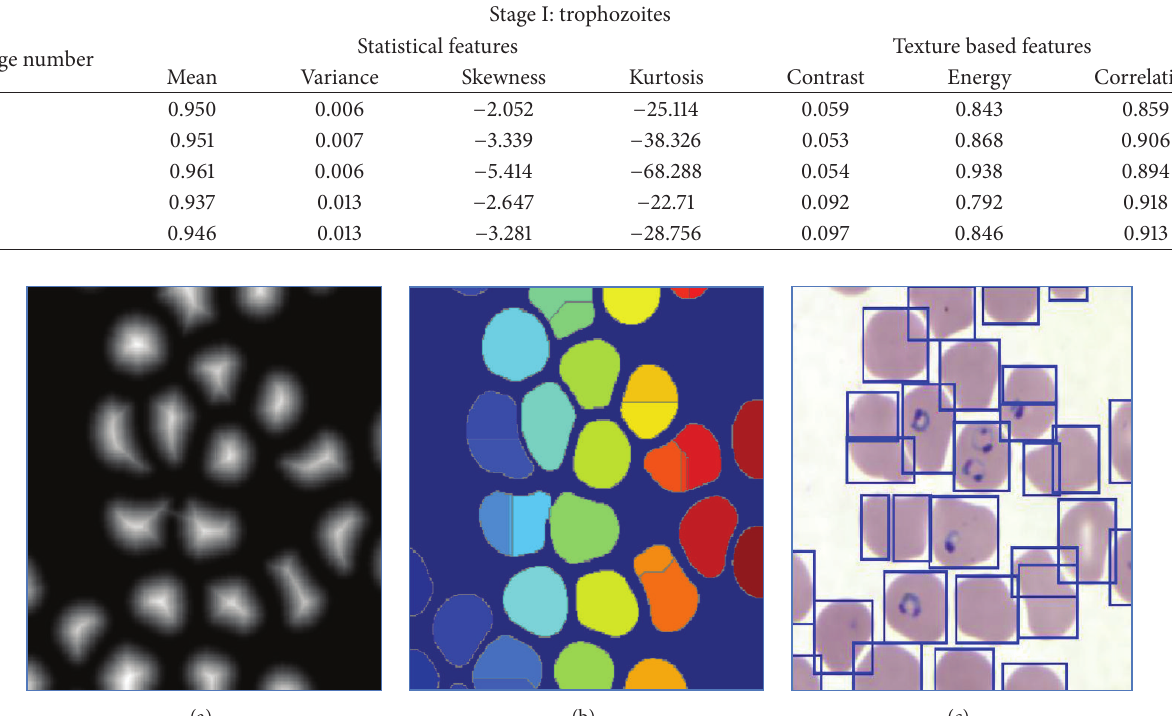
Figure 7: Output obtained after watershed transform (a), distance transform (b), and watershed output (c) after applying major and minor axis